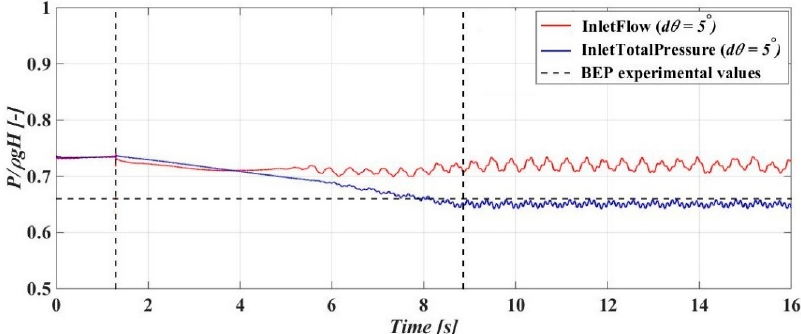
Figure 10. Pressure–time variation (monitor point PS1 in the runner domain). The dotted horizontal line represents the mean pressure measured at the BEP. The dotted vertical lines represent the start and the end of the guide vane closure, respectively.